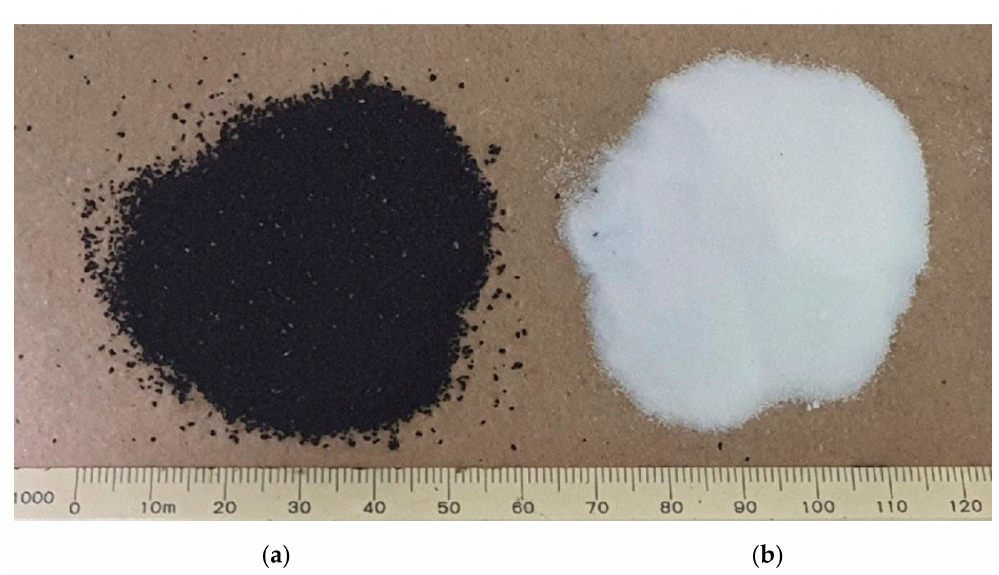
Figure 2. Crumb rubber ( a ) and TPU powder ( b ) used in this